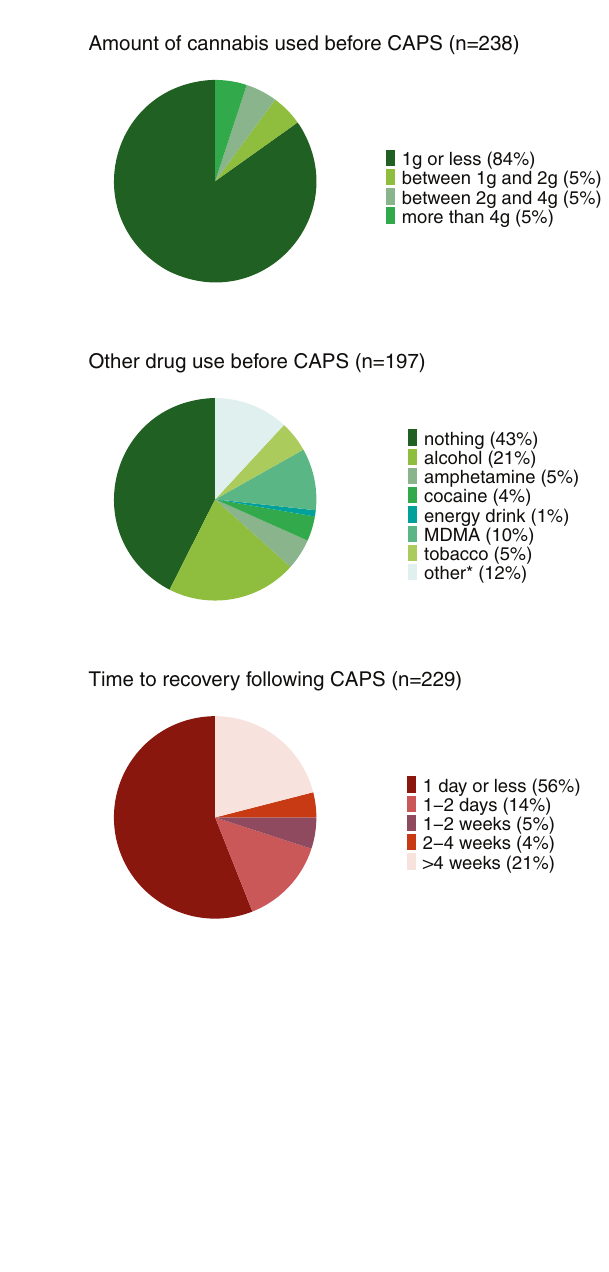
Fig. 3 Characterization of people who use cannabis with cannabis-associated psychotic symptoms (CAPS). Results are plotted for people who use cannabis (PWUC) with last year cannabis-associated psychotic symptoms (CAPS) leading to emergency medical treatment. Depicted are A the surrounding circumstances before the occurrence of CAPS, B information on treatment and recovery of CAPS and C reports on changes in cannabis use following the occurrence of CAPS. All corresponding estimates are provided in Supplementary Table 9, including estimates characterizing PWUC with lifetime CAPS (not plotted here). *Includes all other substances that were reported by 10 or less PWUC with